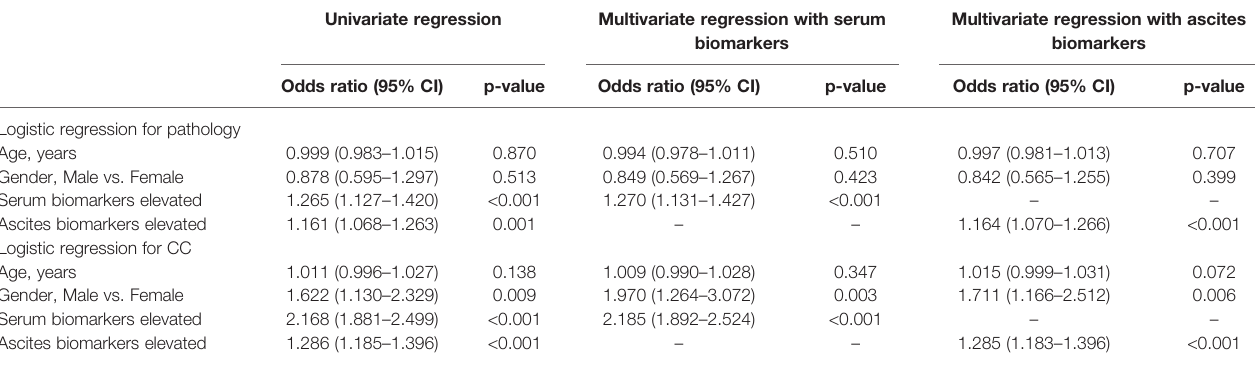
TABLE 3 | The univariate and multivariate logistic regression of biomarkers for pathology and completeness of cytoreduction (CC). Univariate regression Multivariate regression with serum Multivariate regression with ascites biomarkers biomarkers